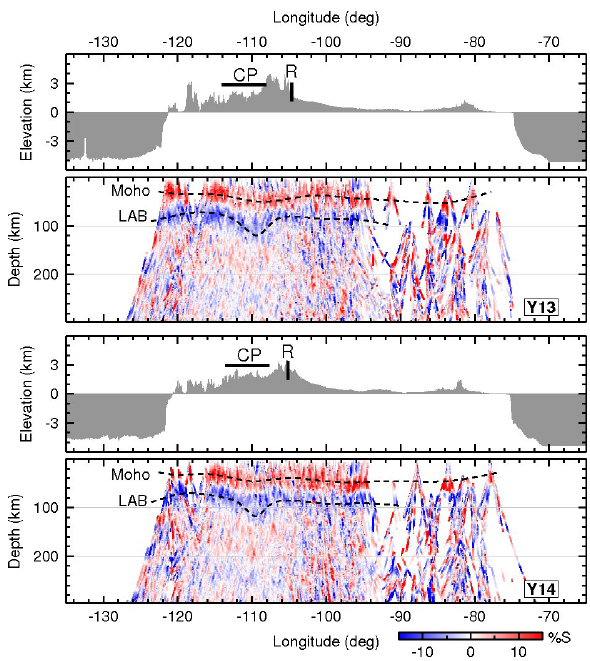
Fig. 9. Migrated S receiver functions along profiles Y13 and Y14 as in Fig. 3. Migrated S receiver functions along profiles Y13 and Y14 as in Fig. 3.